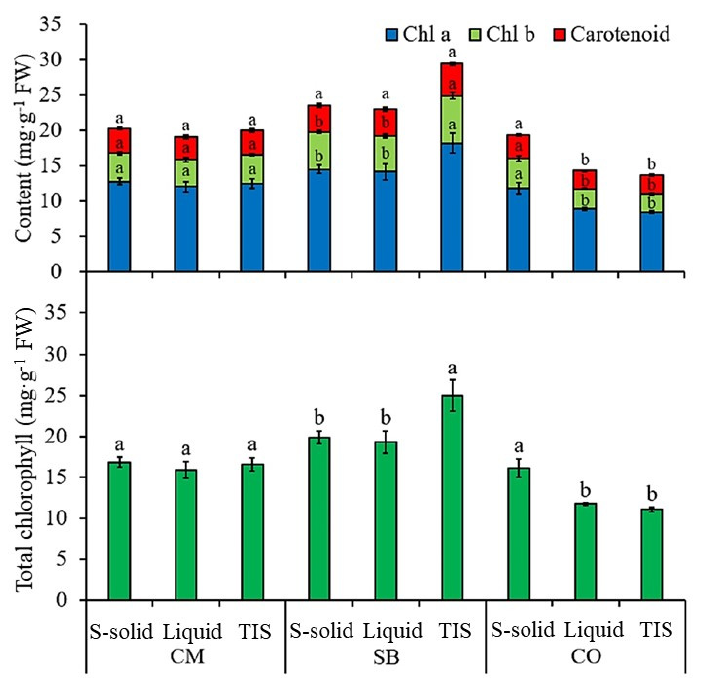
Figure 6. Chlorophyll a, Chlorophyll b, and Carotenoid content of in vitro grown chrysanthemum (CM), strawberry (SB) and Cnidium officinale (CO) plants grown in semi-solid (S-solid), liquid, and TIS cultures. Bars with different letters differ significantly from each other by Duncan’s multiple-range test (DMRT; p ≤ 0.05). Table 1. Comparison of different culture systems on growth of chrysanthemum (CM) , strawberry (SB) and Cnidium officinale (CO) plantlets after 4 weeks of acclimatization.